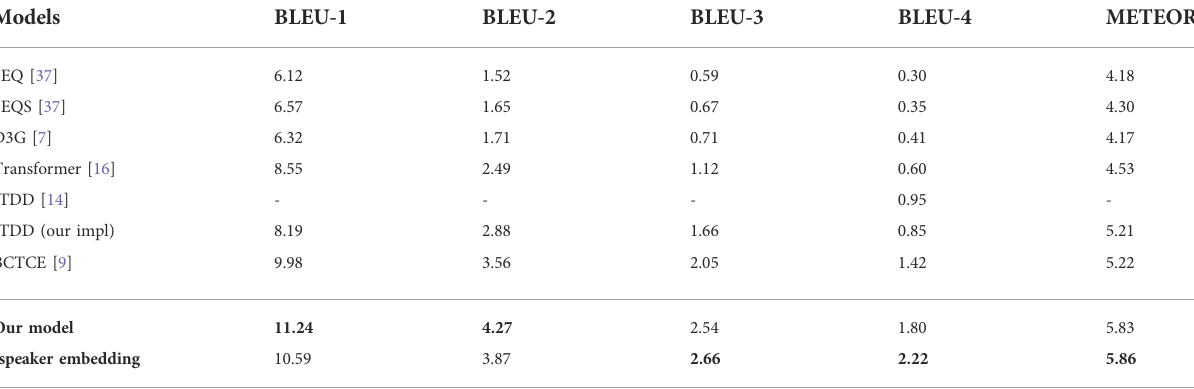
TABLE 3 BLEU − n scores and METEOR scores for baselines and the proposed model. The “ -speaker embedding ” indicates the speaker embedding is removed from the multi-view embedding module of our model. Models